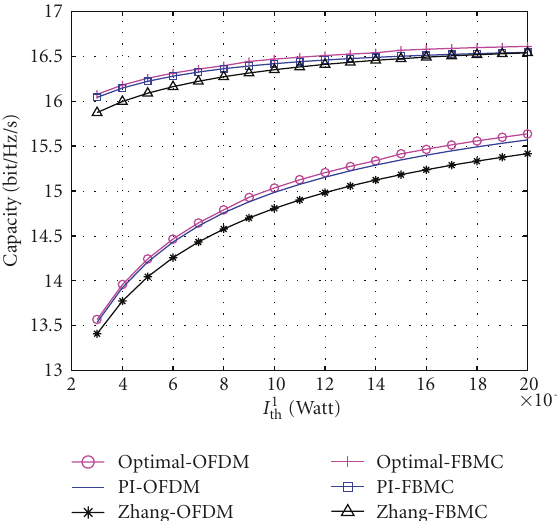
Figure 9: Total interference introduced to the PU 2 versus interfer- ence threshold.